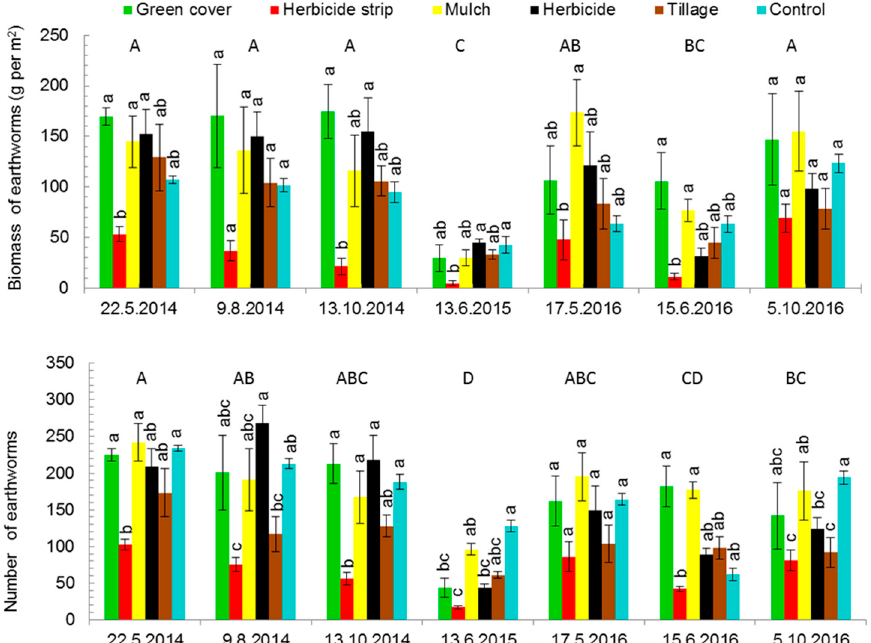
Figure 2. Abundance and fresh biomass (g) of earthworms per m 2 according to different soil management practices in the vineyard from 2014 to 2016. Different lowercase letters denote significant differences among the soil management practices within the sampling term with a > b > c, and uppercase between the sampling terms A > B > C > D ( p ≤ 0.05). Values are mean ± standard error (SE), errors bars are SE.